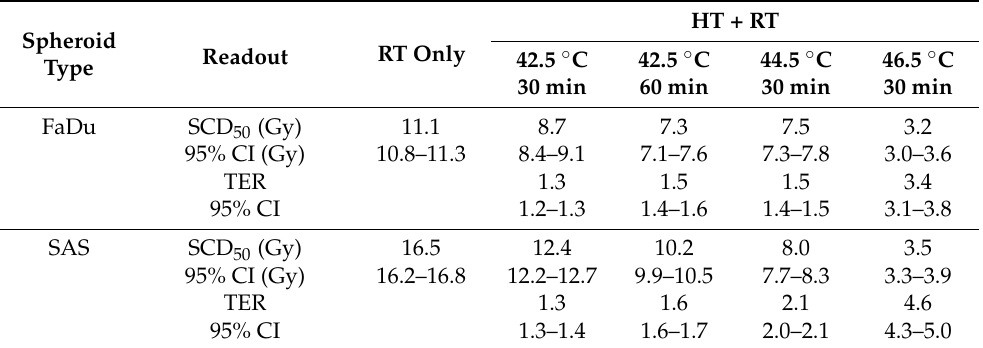
Table 1. SCD 50 and TER values for FaDu and SAS spheroids pre-exposed to different HT doses directly before irradiation. The data were extracted from the SCP curve fittings using function (1), shown in Figure 2c. All treatment-related changes in SCD 50 are significant at a level of p << 0.001 (see Materials and Methods for details on statistics using the pooled data sets from N = 2 independent experiments and Table S4 for interexperimental reproducibility of the TER